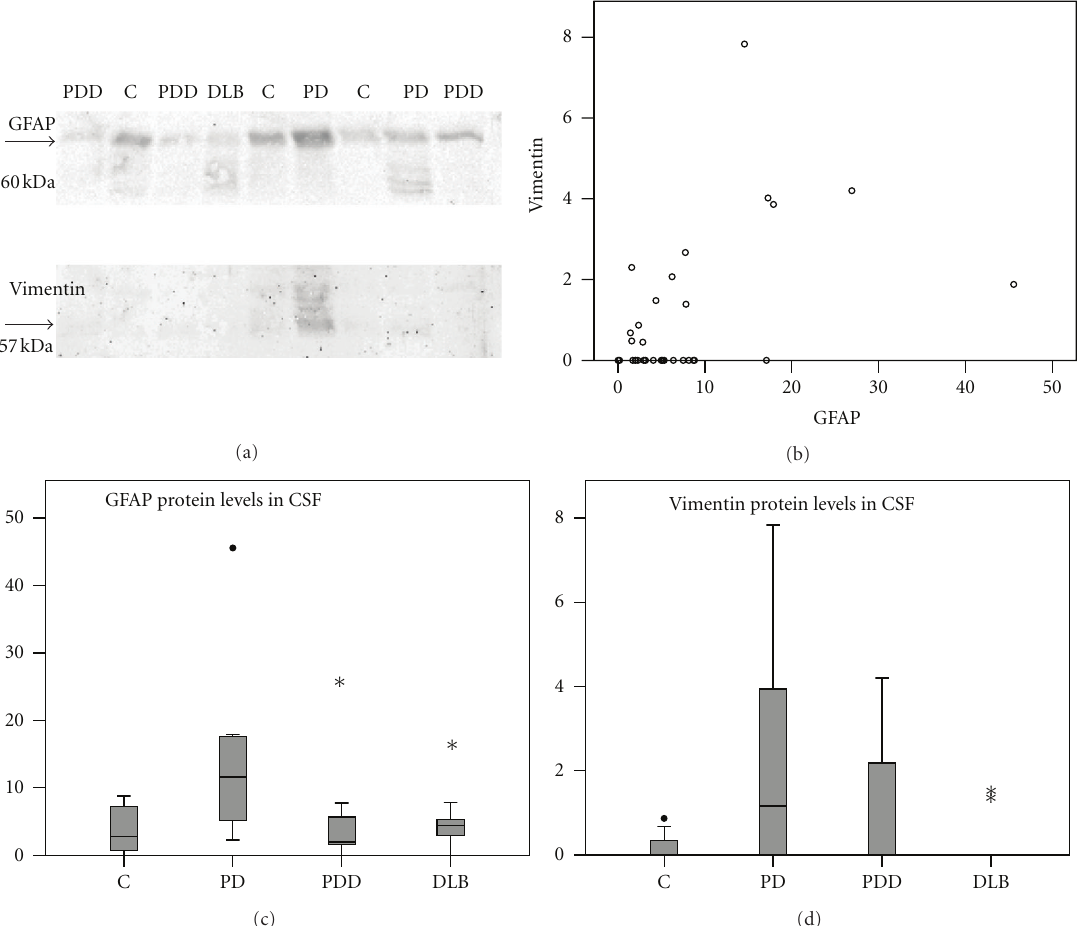
Figure 3: Astrocytic protein levels in ventricular cerebrospinal fluid (CSF). (a) example of a Western blot for GFAP (top row) and vimentin (bottom row) on CSF of di ff erent donors (from left to right: NBB 2006-030, 2007-007, 2007-008, 2007-019, 2005-017, 2005-050, 2005-055, 2005-069, and 2005-077). (b) correlation of the GFAP and vimentin protein levels (in arbitrary units) in CSF of 36 donors. (c) Boxplot of GFAP protein levels in CSF of 8 control (c), 8 Parkinson’s disease (PD), 11 PD with dementia (PDD), and 9 dementia with Lewy bodies (DLB) cases. (d) Boxplot of vimentin protein levels in CSF of 8 C, 8 PD, 11 PDD, and 9 DLB